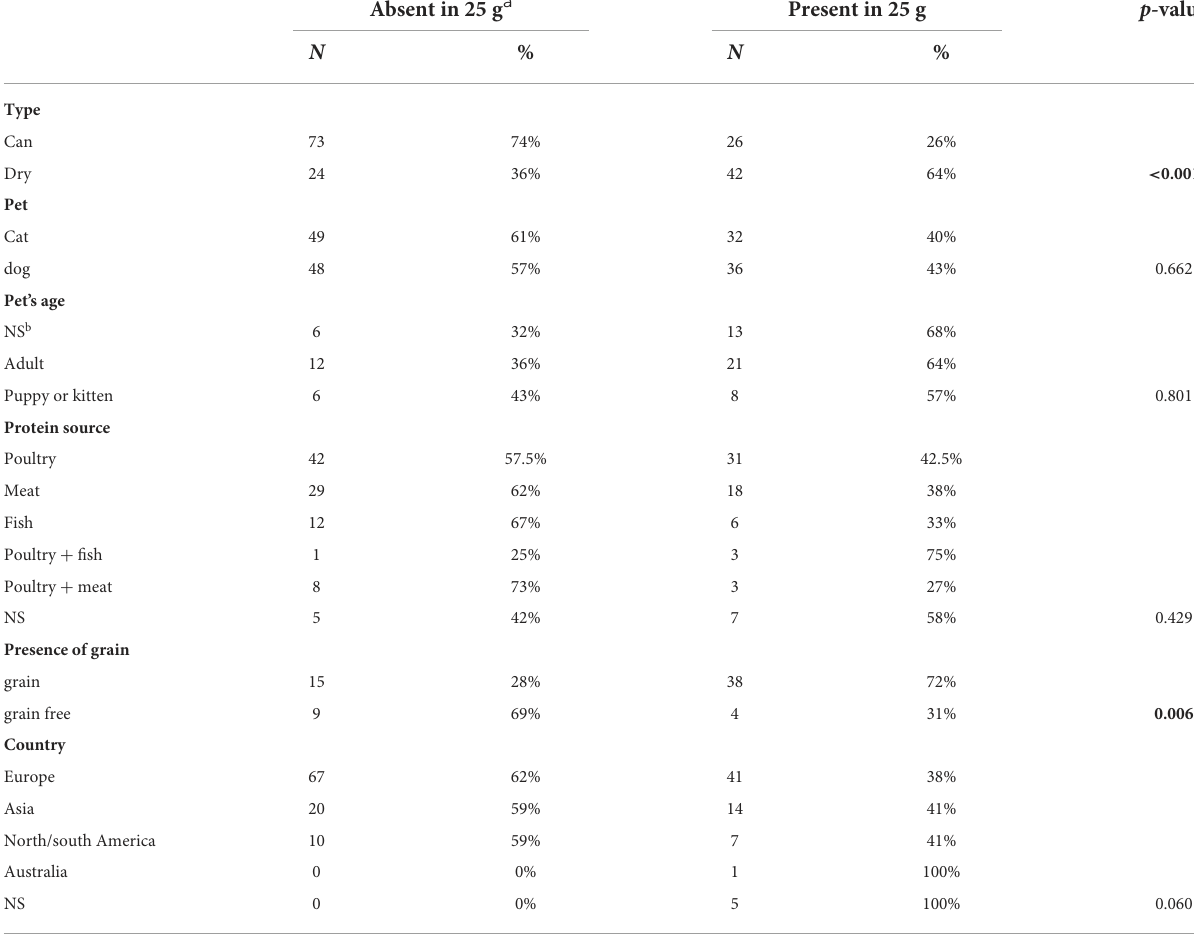
TABLE 4 Microbiological results of presumptive Salmonella spp. in dry and canned pet food. Absent in 25 g